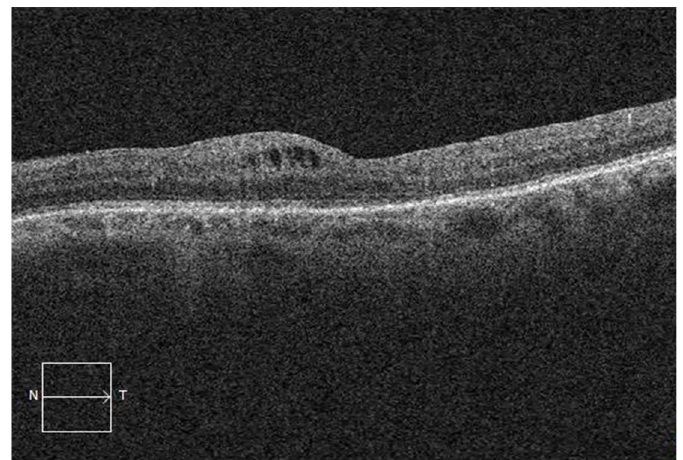
Figure 2. Spectral-domain optical coherence tomography showing cystoid macular edema in both inner and outer retinal layers after vitrectomy for rhegmatogenous retinal detachment.